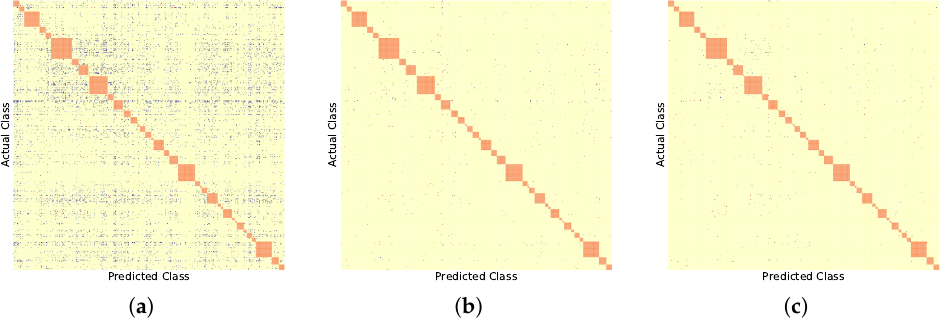
Figure 9. BDCM results on VMMRDB-495 [4] using different model recogniser backbones. Blue, yellow, and red dots mark the positions filled in with 1,0, and − 1, respectively. Orange dots mark the different vehicle models that have the same make. ( a ) AlexNet [15] backbone, (#blue, #yellow, #red) = (9618, 225504, 734). ( b ) ResNet50 [16] backbone, (#blue, #yellow, #red) = (358, 235337, 161). ( c ) DenseNet201 [17] backbone, (#blue, #yellow, #red) = (273, 235450, 133).